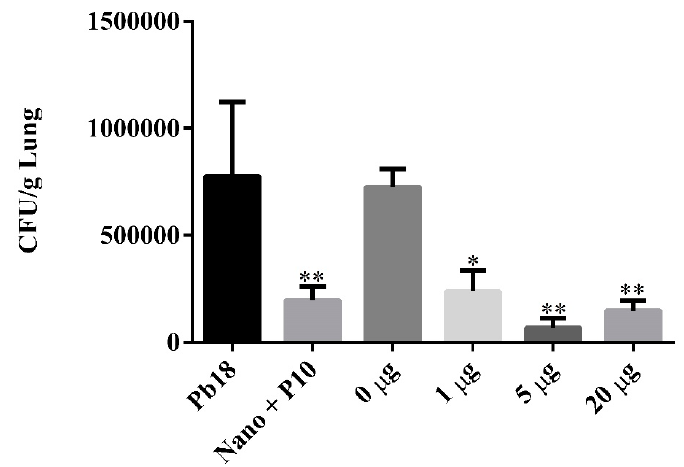
Figure 3. Fungal burden assessed by quantification of colony forming units per gram of lung tissue (CFU/g) in BALB/c mice after 51 days of P. brasiliensis infection. Mice were infected and randomly distributed in the following groups: Pb 18: non-treated; Nano + P10: co-administered vaccine (empty nanoparticles + 20 μ g/10 μ L free-form of P10 peptide); 0 μ g: treated with empty nanoparticles; 1 μ g: